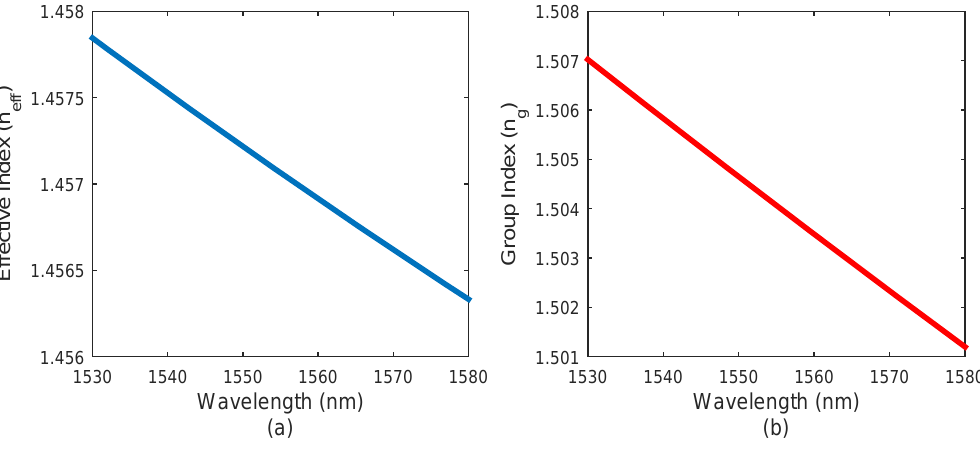
Figure 2. Variation in the ( a ) effective index ( n eff ) and ( b ) group index ( n g ) of the Si 3 N 4 waveguide from the wavelength range from 1530 nm to 1580